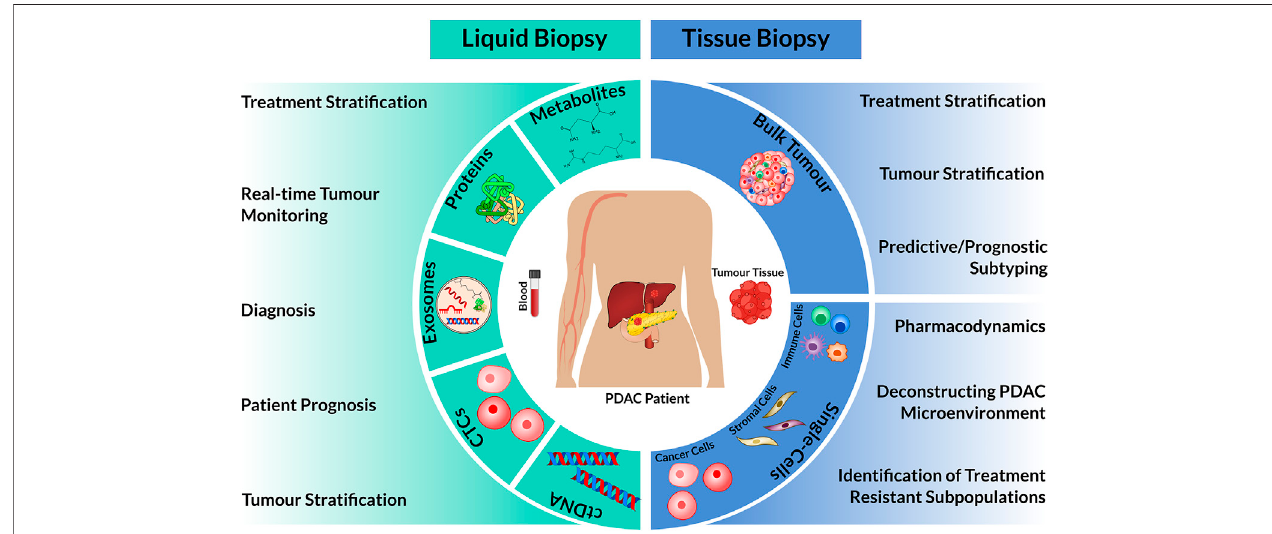
FIGURE 1 | Overview of patient materials isolated from liquid and tissue biopsies for omic analysis and their clinical utility. The circulating biomarkers: cell-free tumourDNA(ctDNA),circulatingtumourcells(CTCs),exosomes,proteinsormetabolitescanbeisolatedandcharacterizedfrombloodspecimens.Incomparison,tissue biopsies extractbulk tumour tissue,whichcanbe used asawhole(Bulk Tumour) or dissociated intosinglecells. In combinationwithomictechnologies, thesebiological materials can have diverse clinical use (left and right)